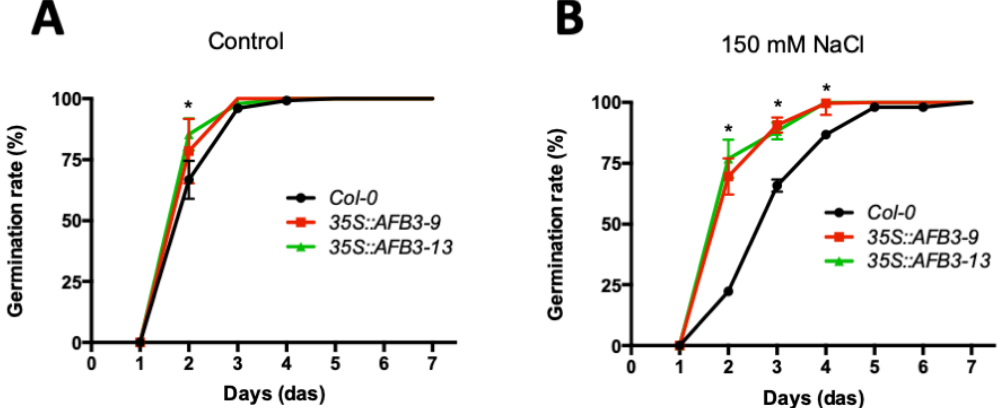
Figure 3. AFB3 over-expression increases germination rates under control and salt stress conditions. Germination rates of Col-0 WT and p35S::AFB3 lines were determined on 0.5× MS medium ( A ) and 0.5× MS medium containing 150 mM NaCl ( B ). One-way ANOVA and Bonferroni a posteriori tests were performed. *: p < 0.05. Error bars represent the standard error of the mean. Each experiment was performed three times with at least 100 seeds per treatment.